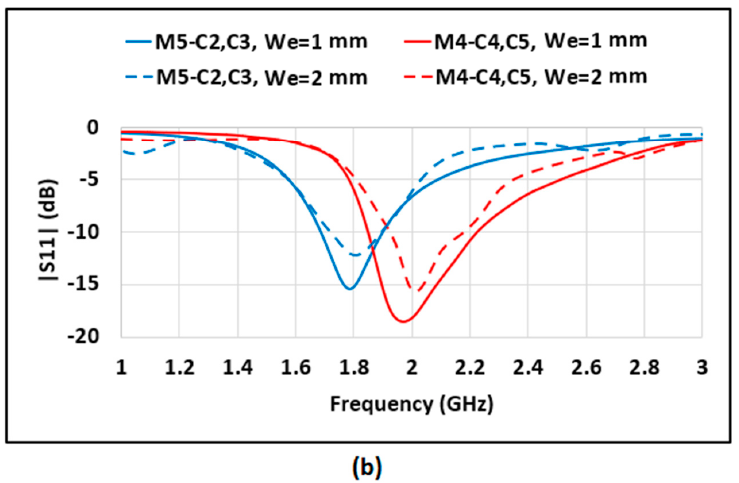
Figure 5. Effect of We’s variation on |S11| of various cases of operating modes ( a , b ).